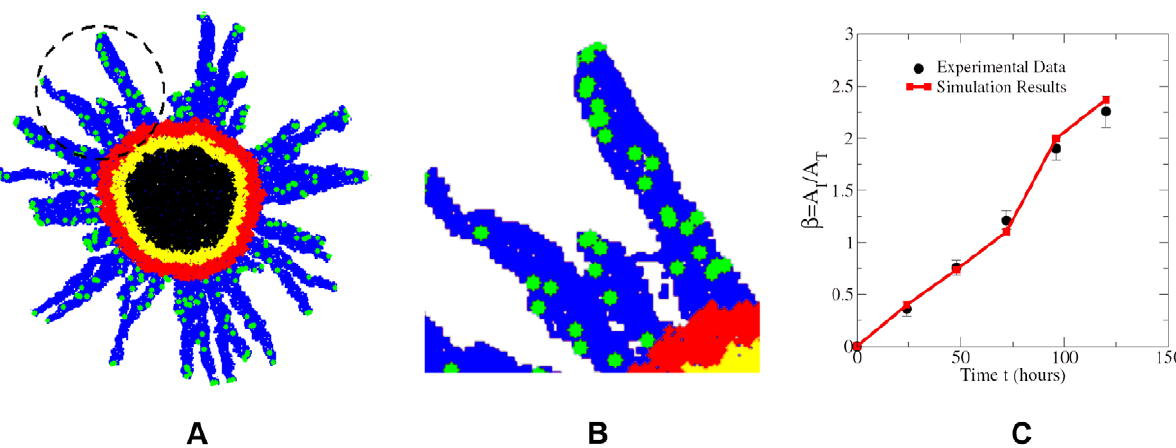
Figure 5. Simulated invasive growth of MTS invitro . (a) A snapshot of the simulated growing MTS at 24 hours after initialization. The region circled is magnified in panel (b). (b) A magnification of the circled region in panel (a). One can clearly see that the invasive cells (green) are following each other to form chains within the dendritic branches (blue), as observed in experiment [4]. (c) Comparison of b ~ A I = A T as a function of time associated with the simulated MTS and the in vitro experimental data [4].